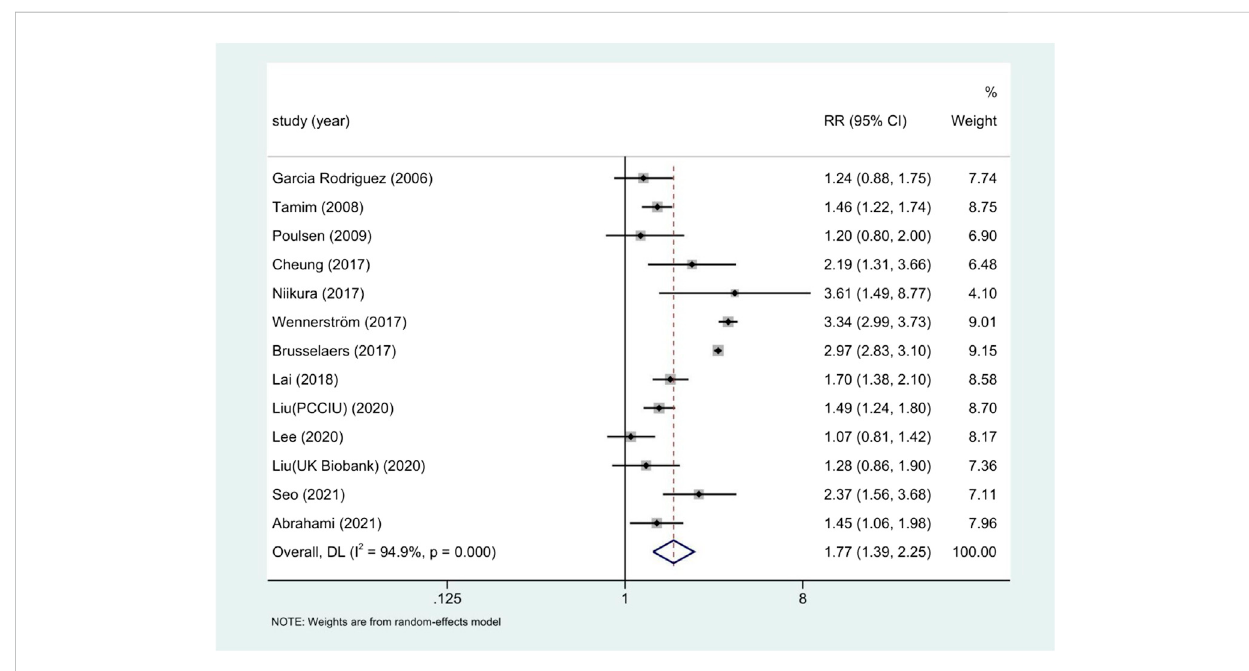
FIGURE 2 Forest plot of long-term use of PPI and the risk of Gastric